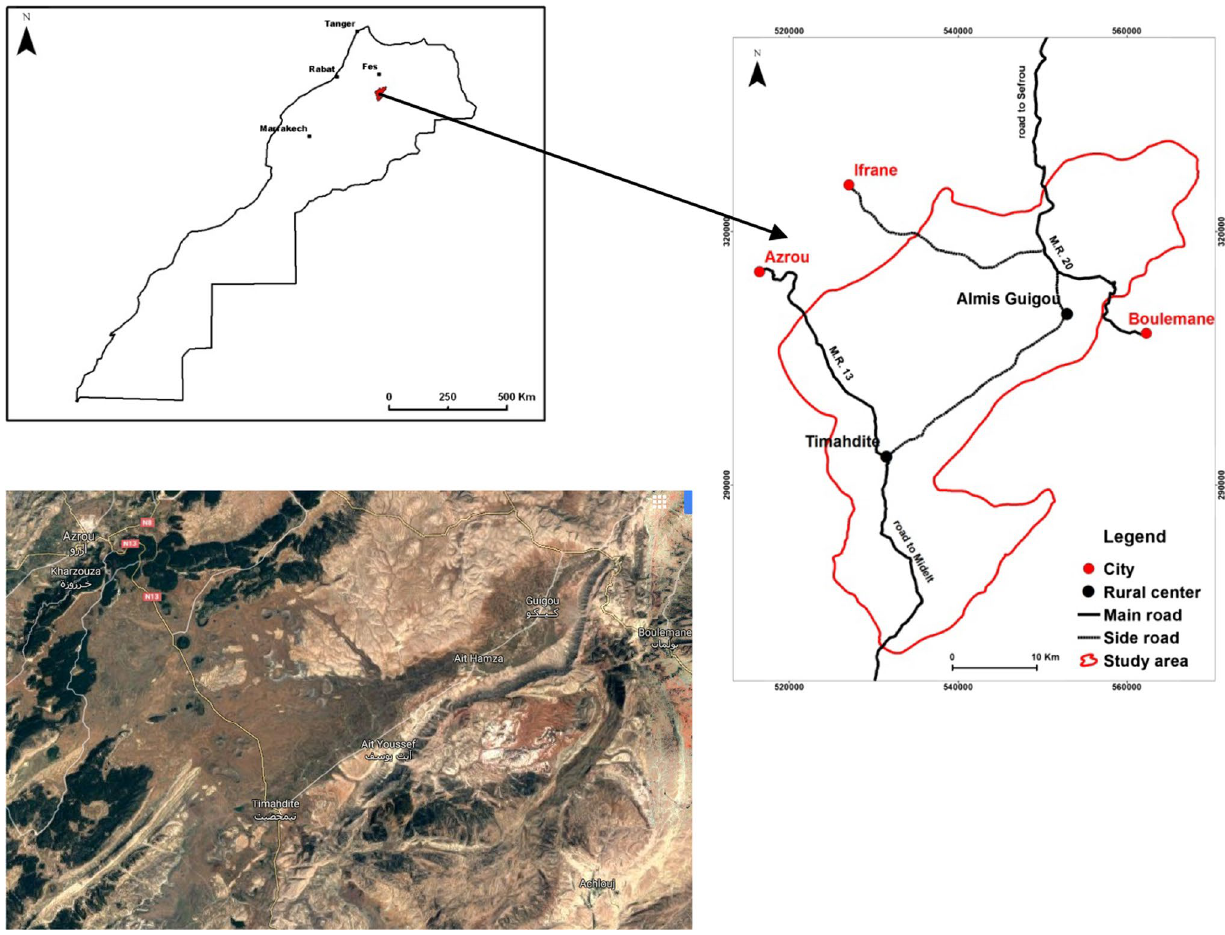
Fig. 1 Geographical location of the study